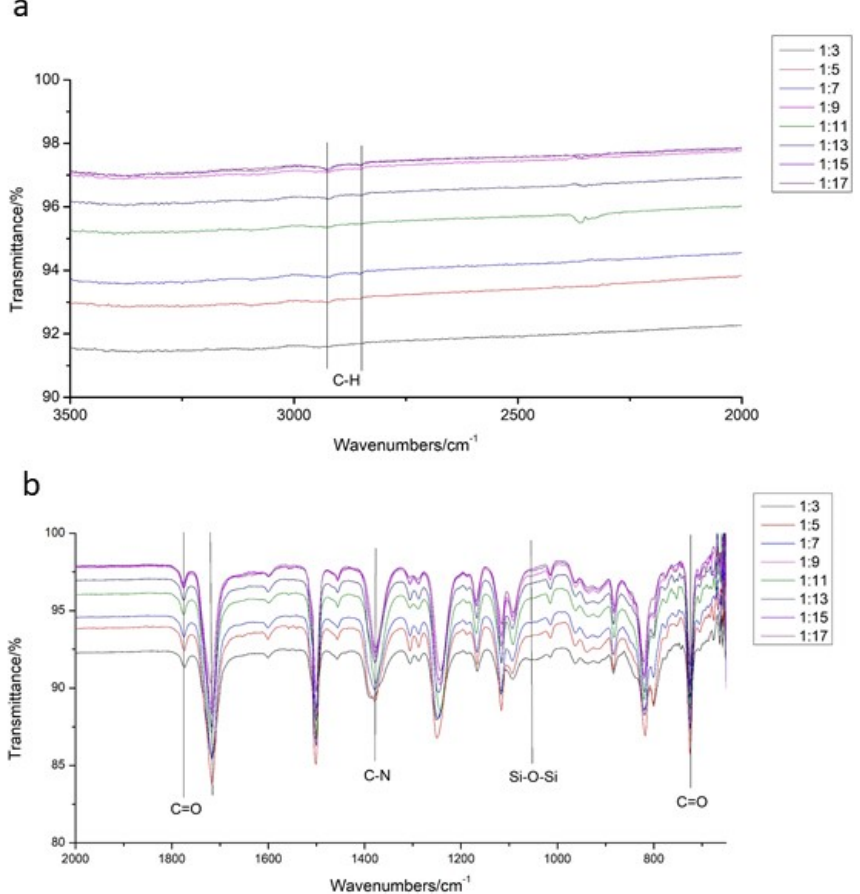
Figure 3. Infrared spectrum of PI films in group 1. ( a ) range of the wavenubers of bond C − H. ( b ) range of the wavenubers of other bonds.